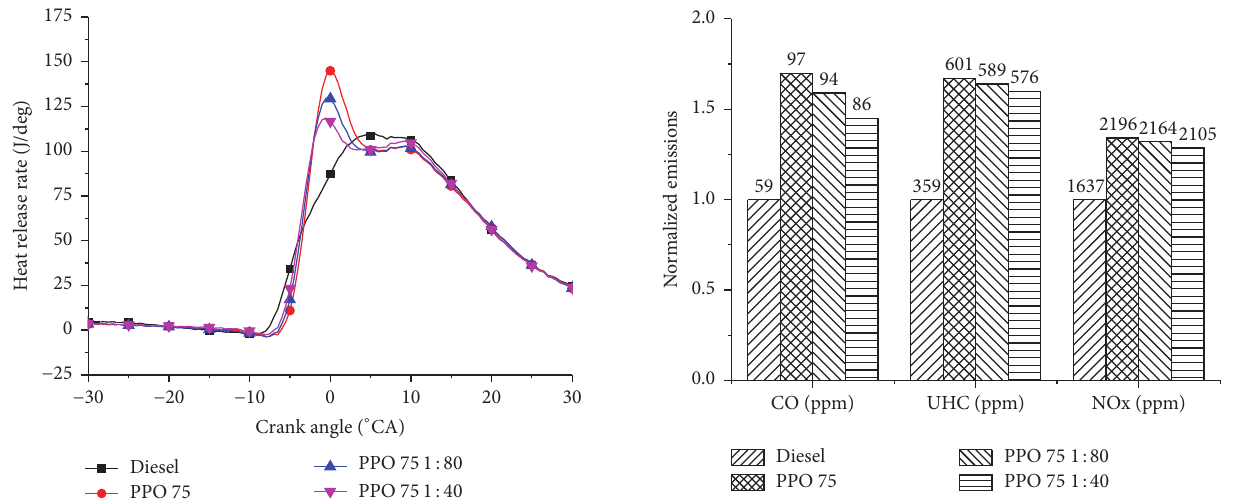
Figure 9: Variation of heat release rate with crank angle at 85% load.